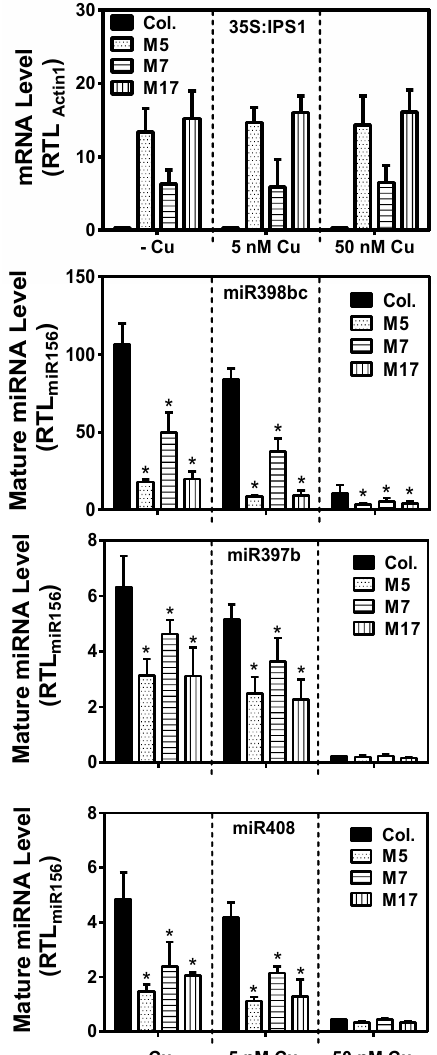
Figure 1. Expression of the IPS1 tandem target mimicry construct and three conserved Cu-microRNAs in wild type (Col) and three transgenic lines (M5, M7, and M17). 35S:IPS1 transgene relative transcript levels (RTL) were determined using qRT-PCR. Values are normalized relative to actin 1 expression. Mature microRNA levels were measured by qRT-PCR using primers designed for miR398bc, miR397b, and miR408. Relative microRNA levels were normalized to miR156 expression. All data and are given as averages ± SD ( n = 3). * indicate significant di ff erences from the control ( p < 0.05, Student’s t -test). We next analyzed the e ff ect of tandem target mimicry on the transcript levels of selected